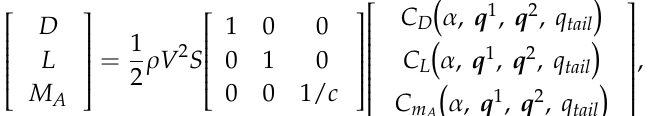
Table 4. Kinematic configurations for each case of study: Configuration 1 serves as a reference; Configs. 2 and 3 affect longitudinal maneuvers; Configs. 4 and 5 affect lateral maneuvers.